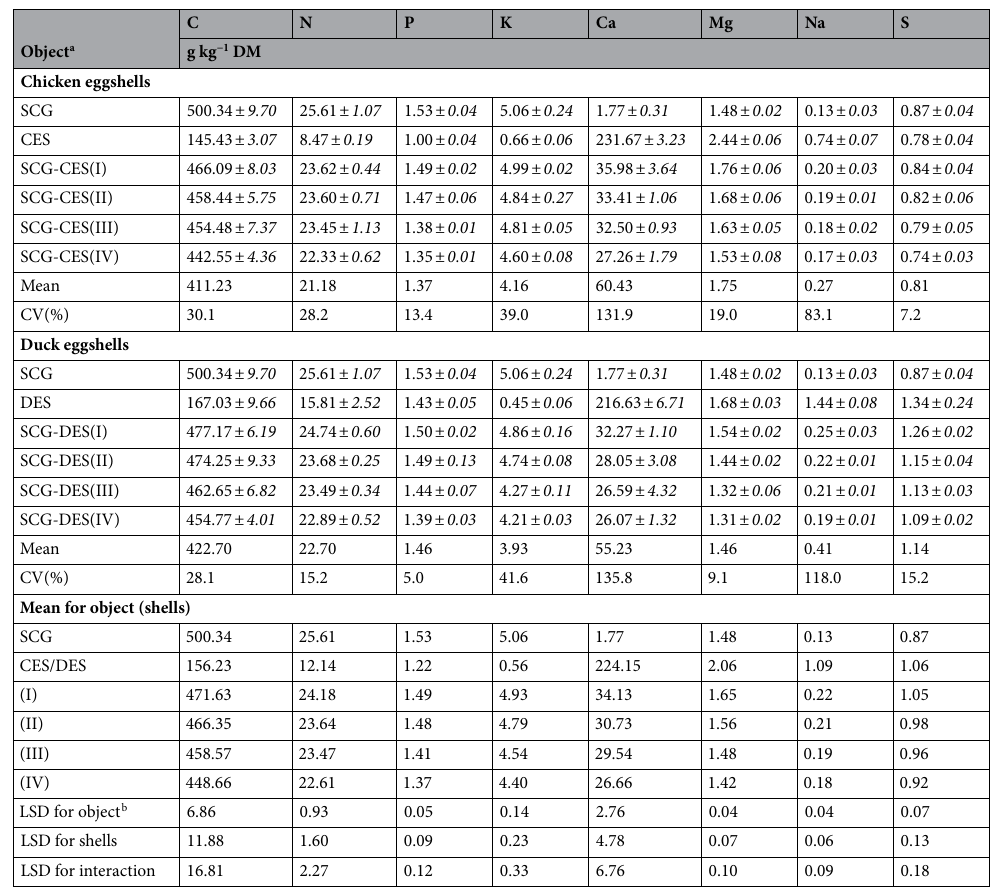
Table 3. Contents of macronutrients in the study objects after 3-month incubation. a Explanations in Table 2. b LSD Least significant